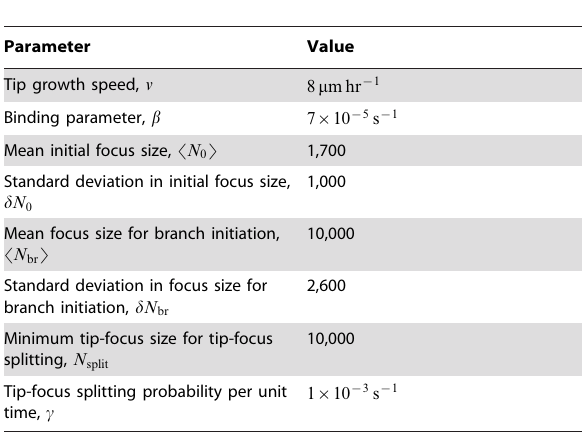
Table 1. Main parameters and their